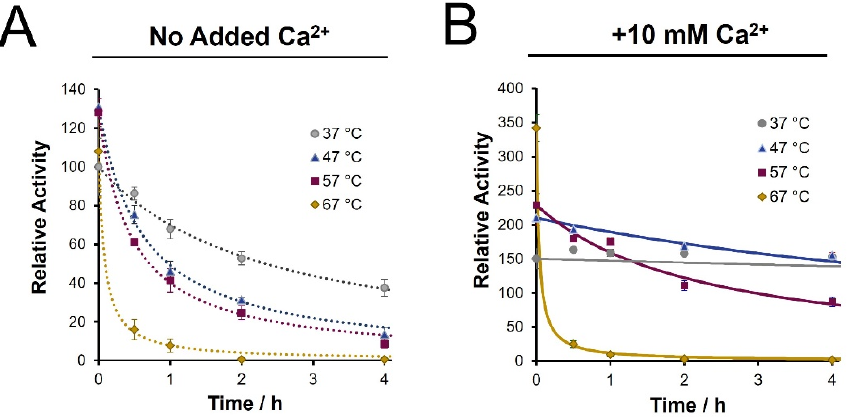
Figure 2. Time course assessment of trypsin activity following pre-incubation (pH 8), as determined by BAEE assay. ( A ) Loss of enzyme activity in the absence of calcium ions is noted at the specified temperatures; ( B ) Inclusion of 10 mM Ca 2+ increases initial activity and sustains enzyme stability up to a maximum 57 °C. All values are normalized to the initial activity at 37 °C in the absence of calcium. Trendlines represent a fit to a second order kinetics model of the form A T = A 0 /{1 + ktA 0 }.